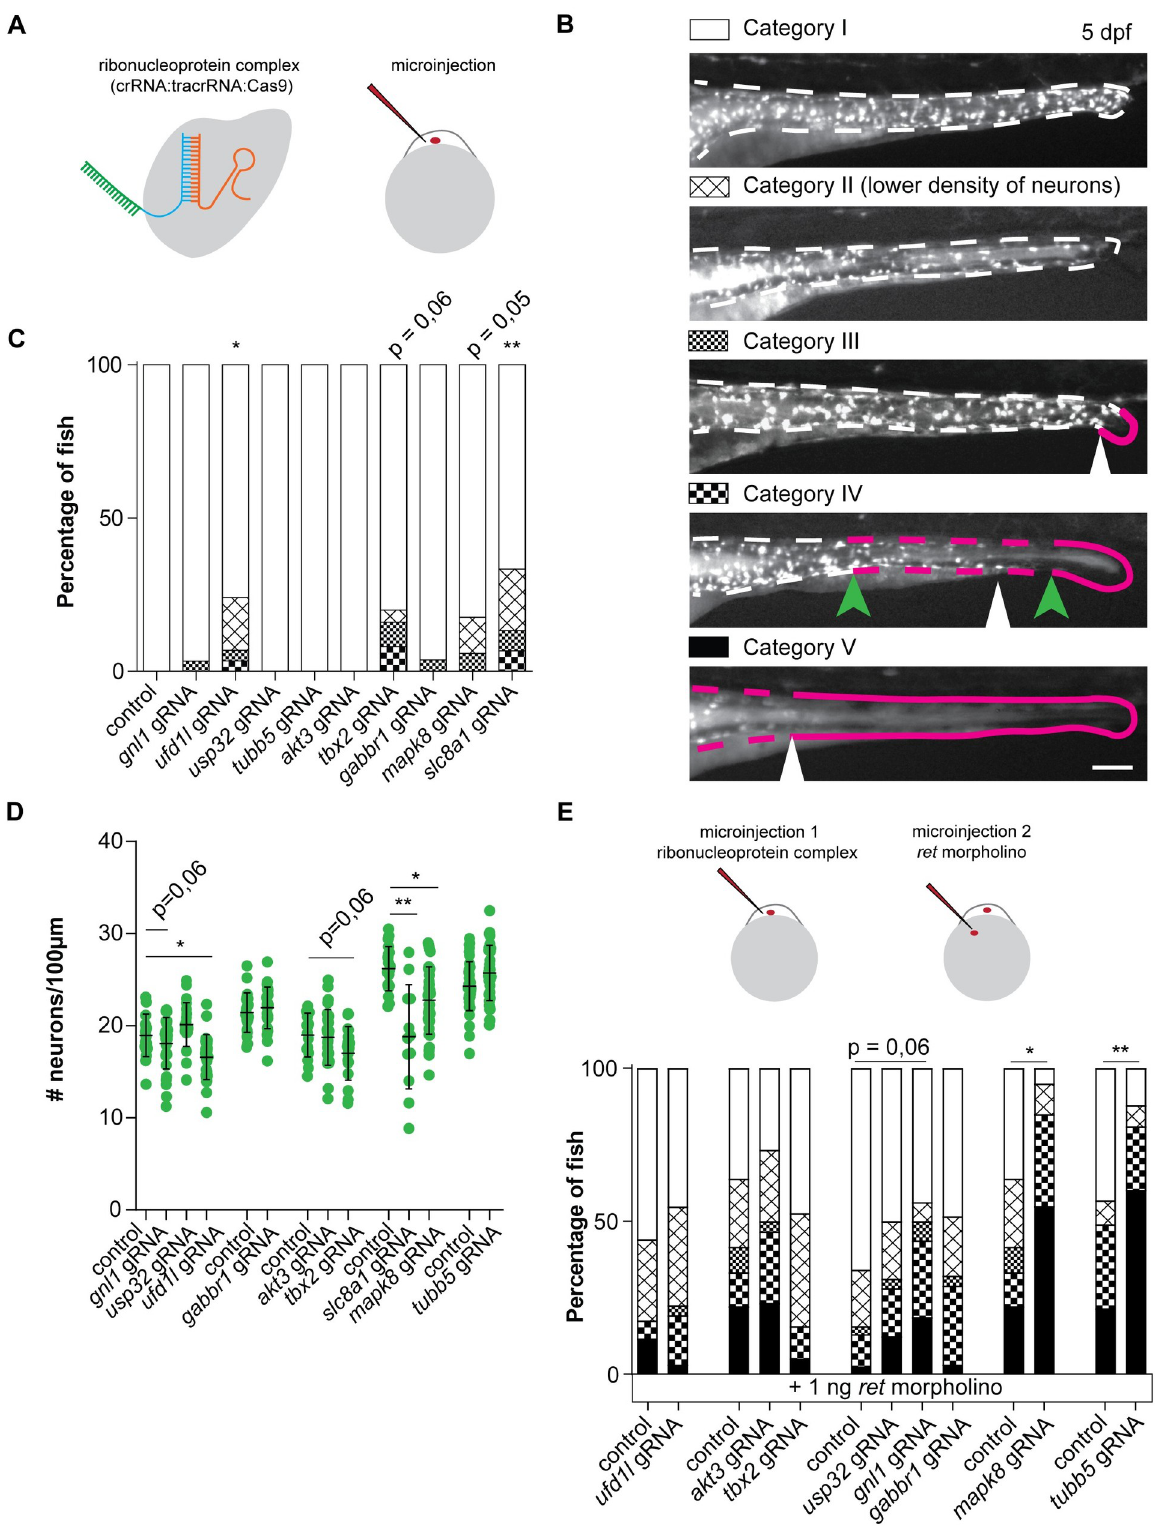
Fig 3. Disruption of candidate genes in zebrafish caused defects in ENS development. (A) Visual representation of the CRISPR/Cas9 complex injections using the Alt-R CRISPR-Cas9 System from Integrated DNA Technologies (IDT) [34]. (B) Legend showing the various